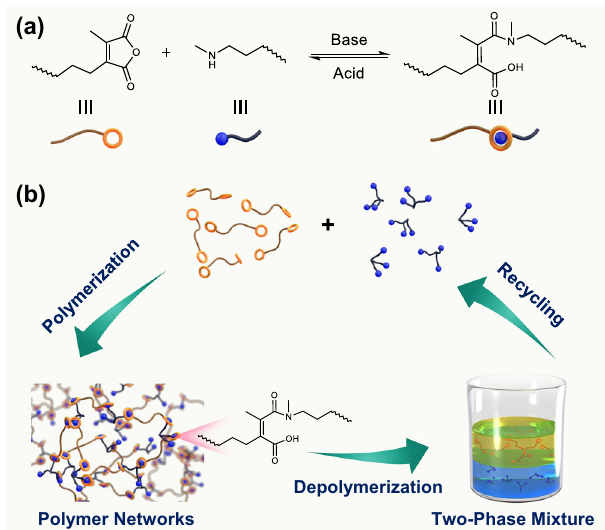
Fig. 1 | Design and closed-loop chemical recycling of cross-linked polymeric materials. Schematic of ( a ) maleic acid tertiary amide bonds constructed from maleicanhydridesandsecondaryamines;and( b )polymernetworkspreparedfrom bifunctional maleic anhydrides and multifunctional secondary amines and their depolymerization in acid aqueous solution. Two monomers can be separated and regained in a closed-looped recycling